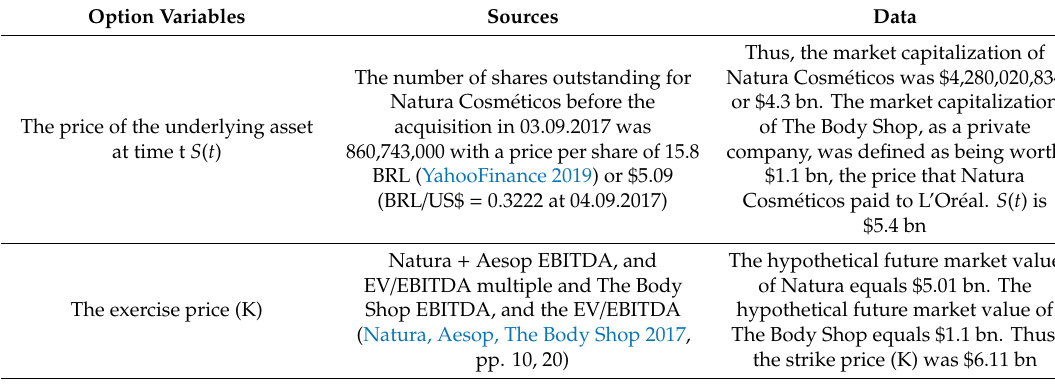
Table 3. Data and methodology to measure competence-based synergies of Natura and The Body Shop’s M&A deal with a real options